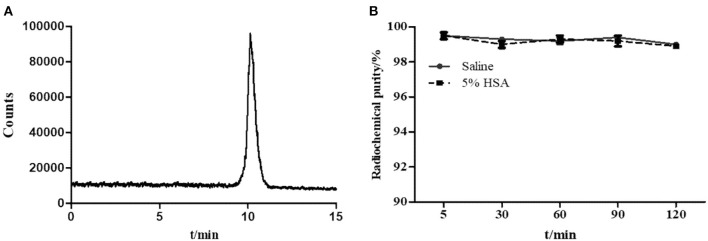
(A) Radio-HPLC pattern of Al18F-PSMA-CM. (B) The radiochemical purity of Al18F-PSMA-CM in saline and 5% HSA at 37°C for 4 h.